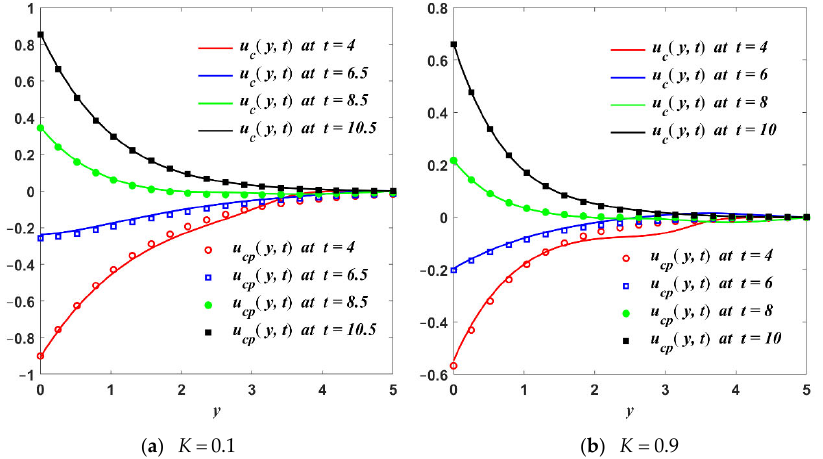
Figure 7. Convergence of starting velocity u c ( y , t ) (numerical solution) to its steady-state component u cp ( y , t ) for α = 0.8, β = 0.7, γ = 0.6, ω = π /12, M = 0.6, and two values of K